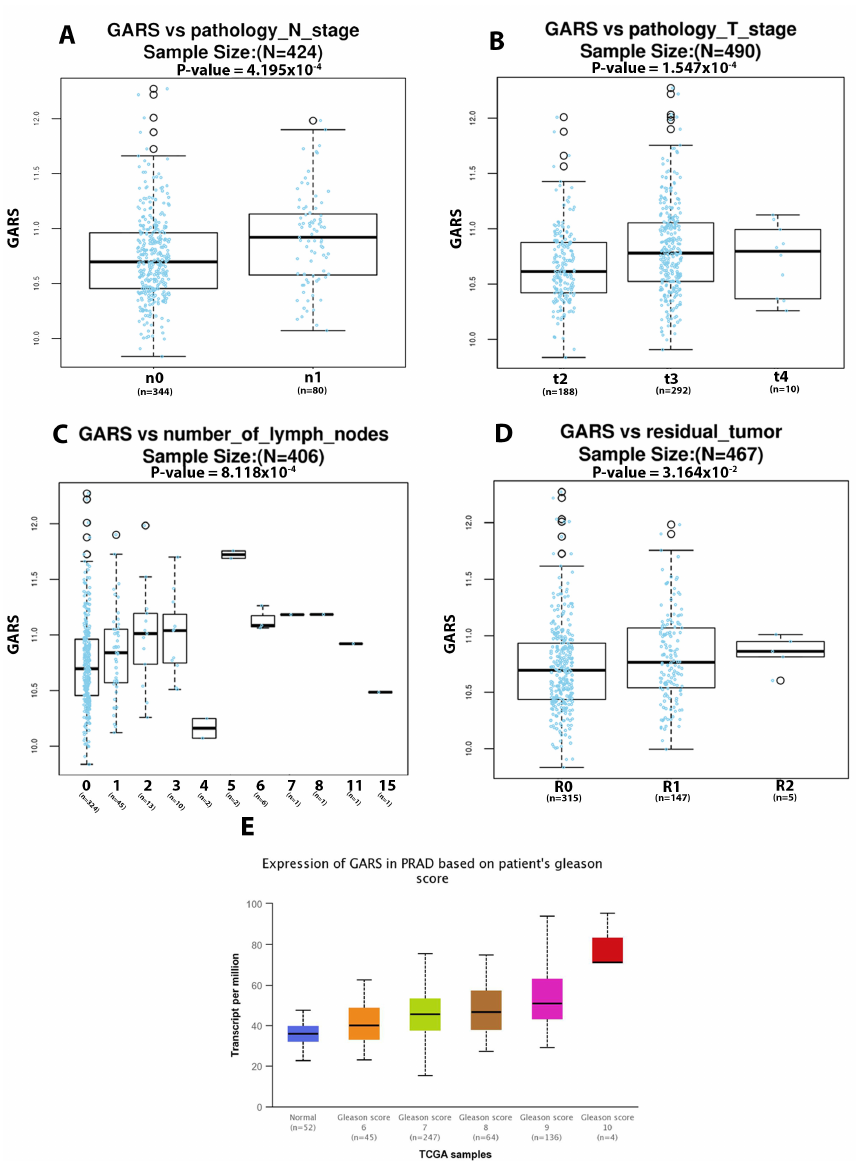
Figure 4. Gene expression analysis of GARS in relation to clinical features from TCGA PRAD database. Boxplots represent GARS RNA-seq gene expression in relation to ( A ) pathological nodal stage involvement assessed using Wilcox Test (n0 = no cancer in lymph nodes, n1 = cancer in lymph nodes), ( B ) pathological tumor stage assessed using Kruskal–Wallis Test (Stage 2, Stage 3, Stage 4), ( C ) number of lymph nodes involved assessed using Kruskal–Wallis Test, and ( D ) residual tumor levels assessed using Kruskal–Wallis test (R0 no residual tumor, R1 = microscopic residual tumor, R2 = macroscopic residual tumor. ( E ) Gleason score assessed via Welch’s T -Test. p -value for normal versus Gleason score 6, 7, 8, 9 (2.57 × 10 − 2 , 2.12 × 10 − 12 , 9.82 × 10 − 8 , 1.11 × 10 − 16 ,